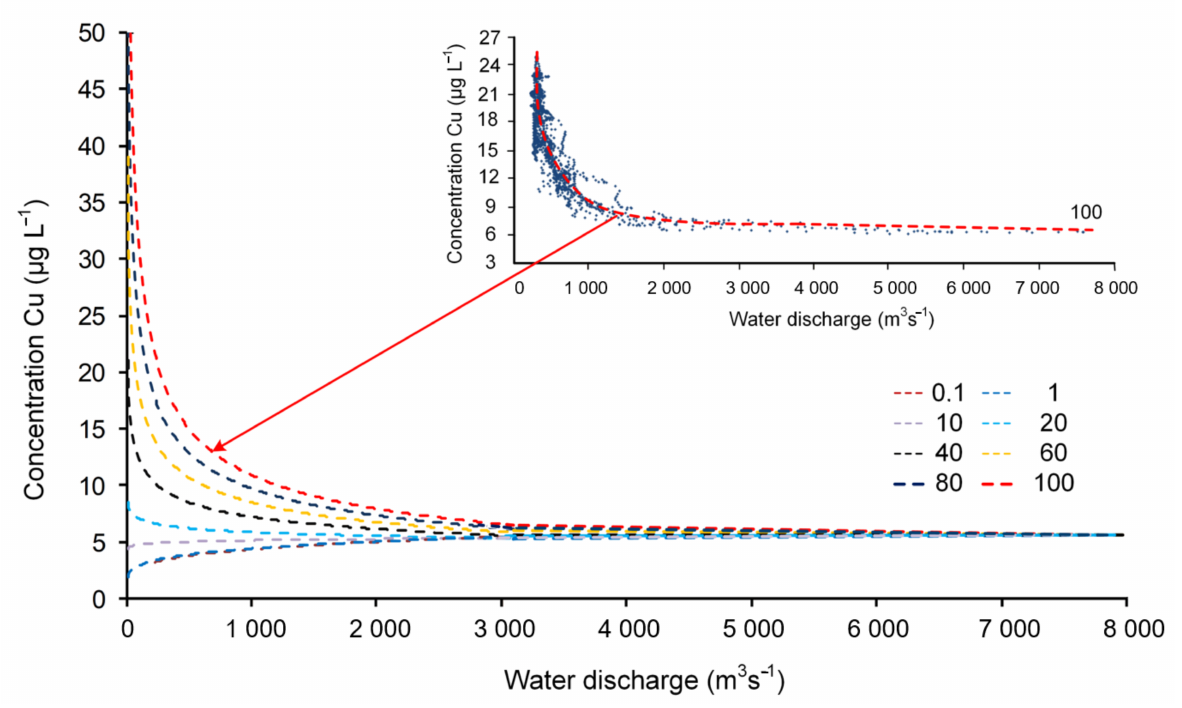
Figure 9. Relationship between water discharges at the Belaya River (Ufa city) and the concentration of copper in river water with the actual content of copper in wastewater (1) and under scenarios of its change at 0.1, 10, 20, 40, 60, 80, 100